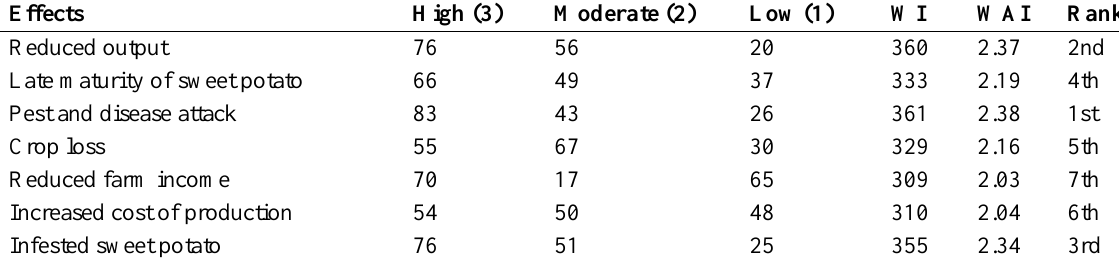
Table 4: Effects of climate change perceived by respondents (n = 152).